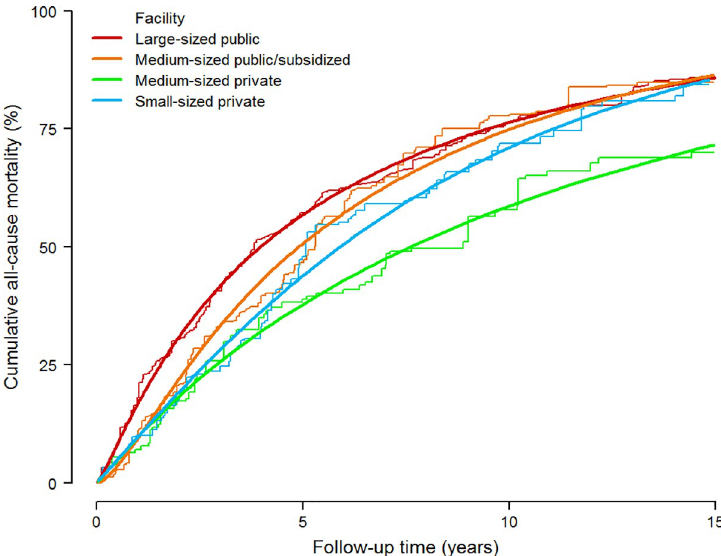
Fig 1. Standardized cumulative all-cause mortality by type of facility among institutionalized residents in Madrid, Spain. Parametric cumulative mortality curves (smooth lines) were estimated from a spline-based survival model and nonparametric cumulative mortality curves (step functions) from Kaplan-Meier methods, both weighted by combined inverse probability weights and stratified by type of facility. Combined weights were used to standardize cumulative mortality curves in each type of facility to the weighted distribution of baseline confounders in the overall institutionalized population, including age (65–74, 75–79, 80–84, 85–89, or � 90 years), sex (female or male), educational level (less than primary or primary or more), length of stay in the nursing home ( < 3 or � 3 years), dementia (yes or no), number of chronic conditions other than dementia (0–2 or � 3), and functional dependency (no/ mild, moderate, or